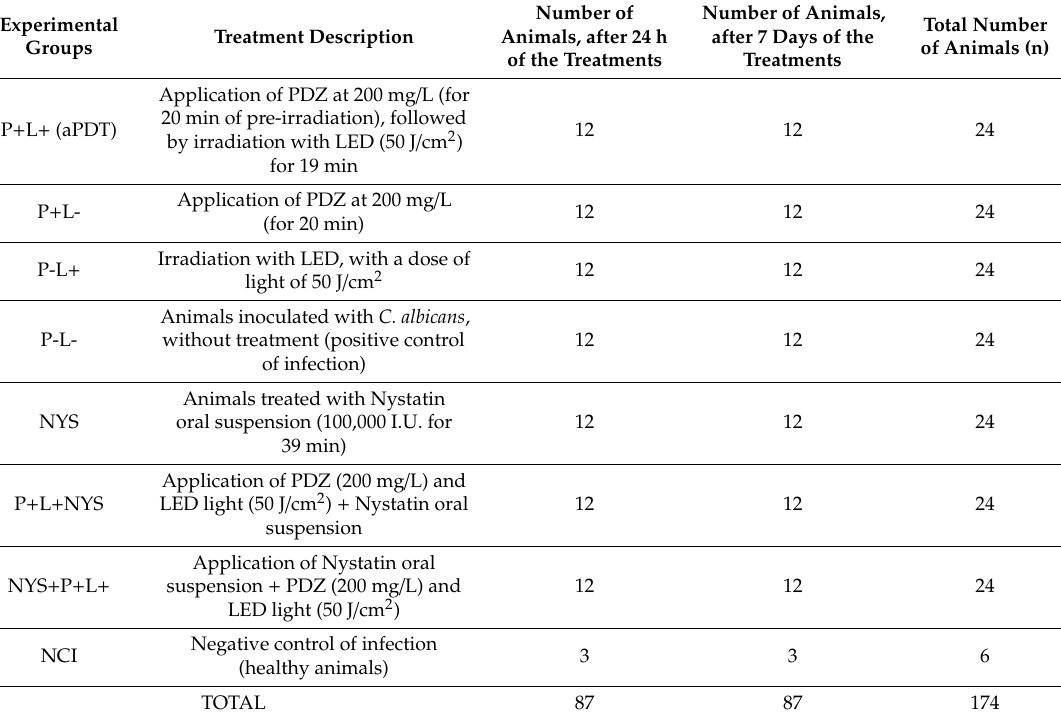
Table 1. Description of the experimental groups, dosage regime and number of animals used. Experimental